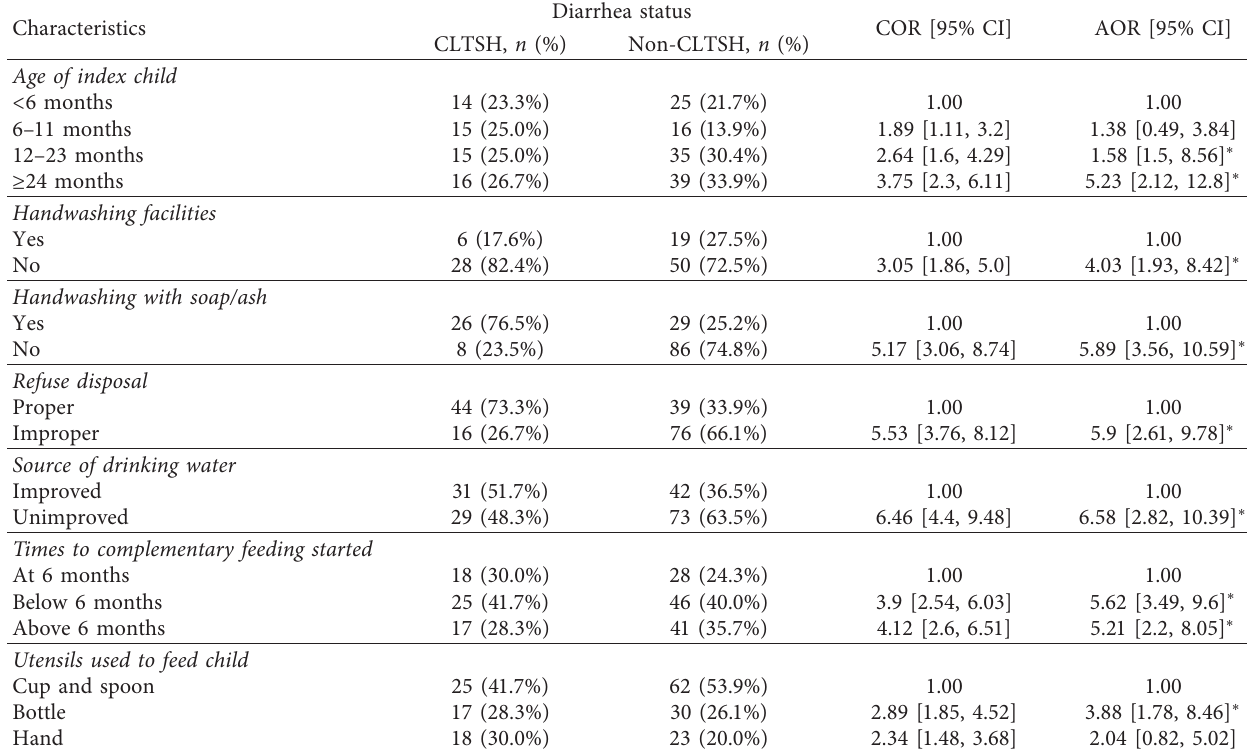
Table 8: Multivariable analyses of factors related to diarrhea among under-five in selected CLTSH implemented and nonimplemented woredas in Gamo Gofa Zone, March